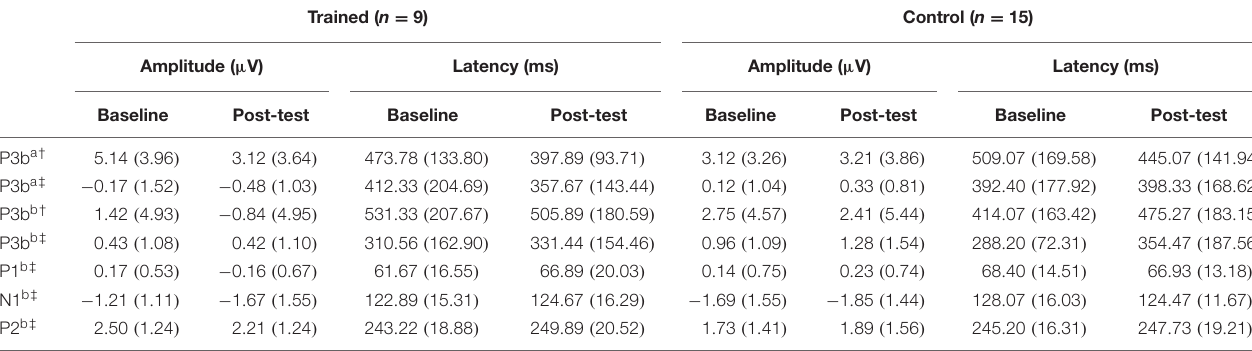
TABLE 3 | Mean amplitudes and peak latencies for P3b and P1-N1-P2 at baseline and post-test per group. Trained ( n = 9) Control ( n =